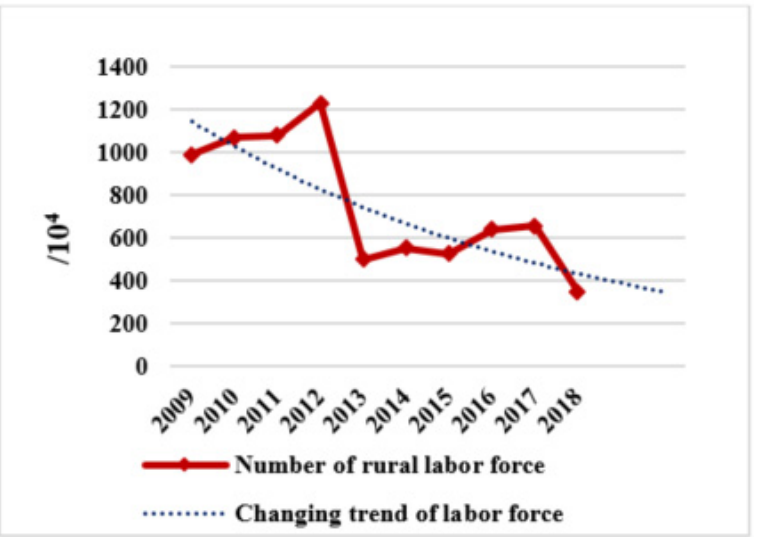
Figure 5. The size of the labor force in the Loess Plateau (2009–2018).